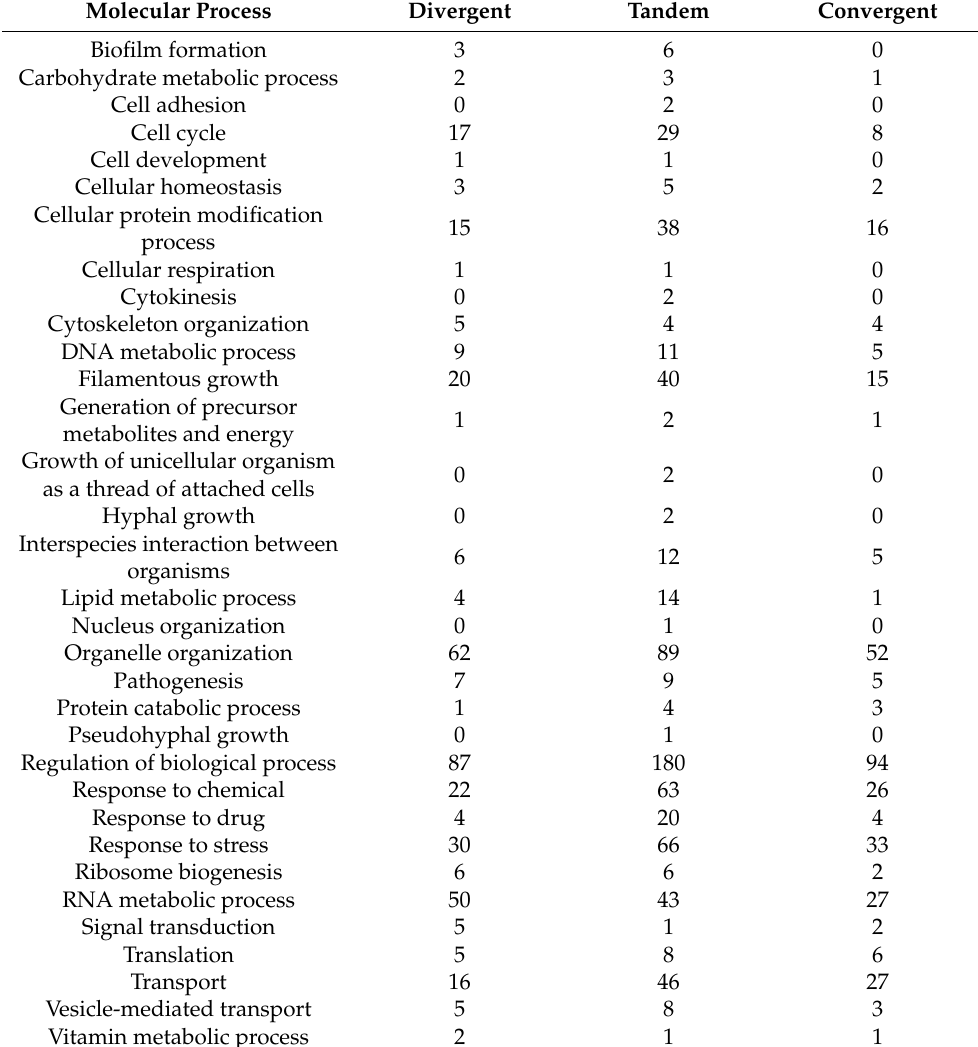
Table 3. Orientation of Functional